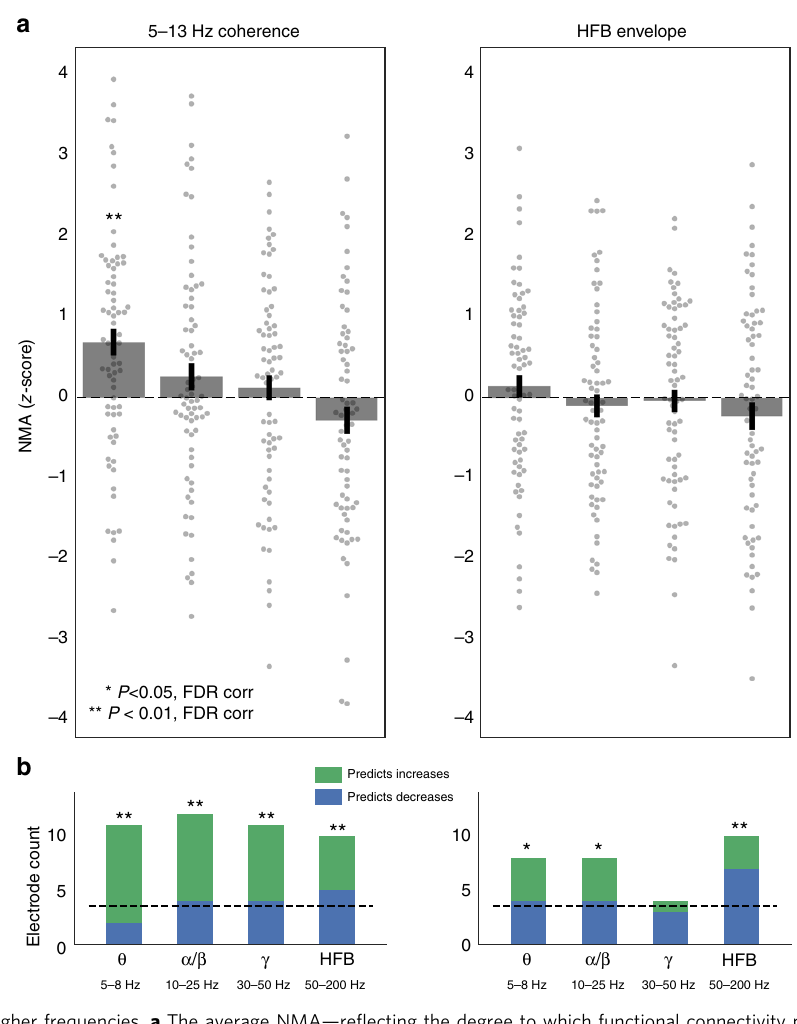
Fig. 7 Power response at higher frequencies. a The average NMA — re fl ecting the degree to which functional connectivity predicts changes in spectral power — was computed for theta (5 – 8 Hz), alpha/beta (10 – 25 Hz), gamma (30 – 50 Hz), and HFB (50 – 200 Hz) bands for all 72 MTL stimulation sites. Functional connectivity was measured as 5 – 13 Hz coherence (left) and HFB amplitude correlation (right; see Methods for details). Across all stimulation sites, 5 – 13 Hz coherence signi fi cantly predicted changes in theta power, as demonstrated in Fig. 2 (one-sample t -test, t (71) = 4.18, corrected P < 0.01). HFB amplitude correlations did not signi fi cantly predict power changes in any band. b To account for the fact that connectivity could predict decreases or increases in power, each stimulation site was classi fi ed by whether its functional connectivity pro fi le signi fi cantly predicted decreases (blue) or increases (green) power (two-tailed P < 0.05). The count of signi fi cant stimulation sites are depicted as stacked bars; the expected false positive rate ( P = 0.05) is indicated as a dashed line. Note that though HFB amplitude correlations do not signi fi cantly predict changes in HFB power on average ( a ), the count of stimulation sites where connectivity signi fi cantly predicts changes in HFB power is signi fi cantly greater than chance (7 decreases, 3 increases; binomial test, corrected P < 0.01). Error bars show ±1 SEM; *corr. P < 0.05; **corr. P <